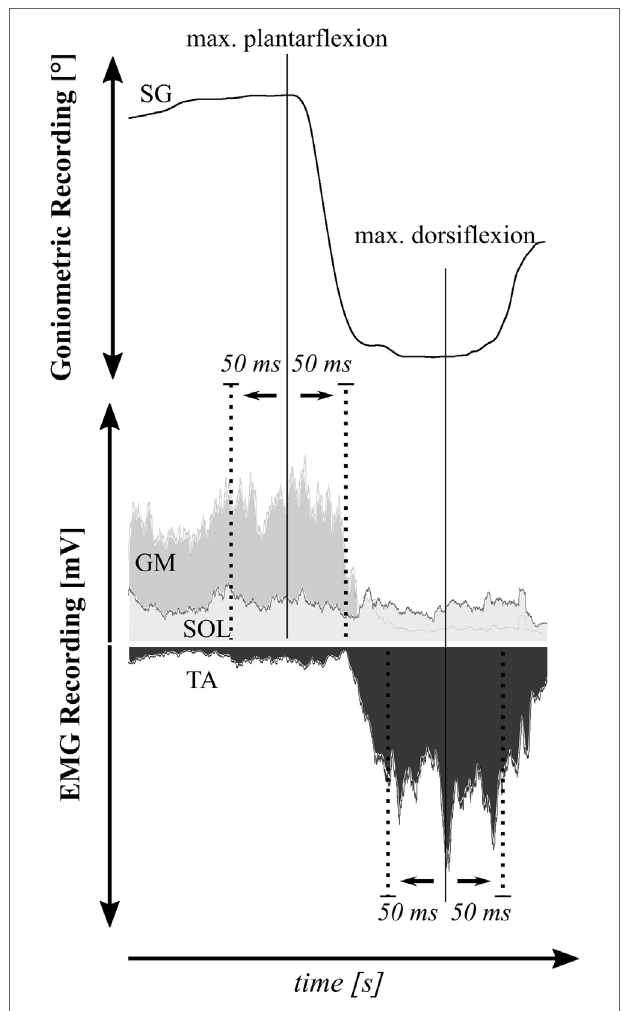
FigUre 2 | Exemplary illustration of the co-activation ratio determination in the shank: EMG activity of agonists was evaluated in relation to antagonists 50 ms before and 50 ms after peak joint excursion during max. plantarflexion for m. soleus (SOL) EMG and m. gastrocnemius medialis (GM) EMG and during maximal dorsiflexion for m. tibialis anterior (TA)